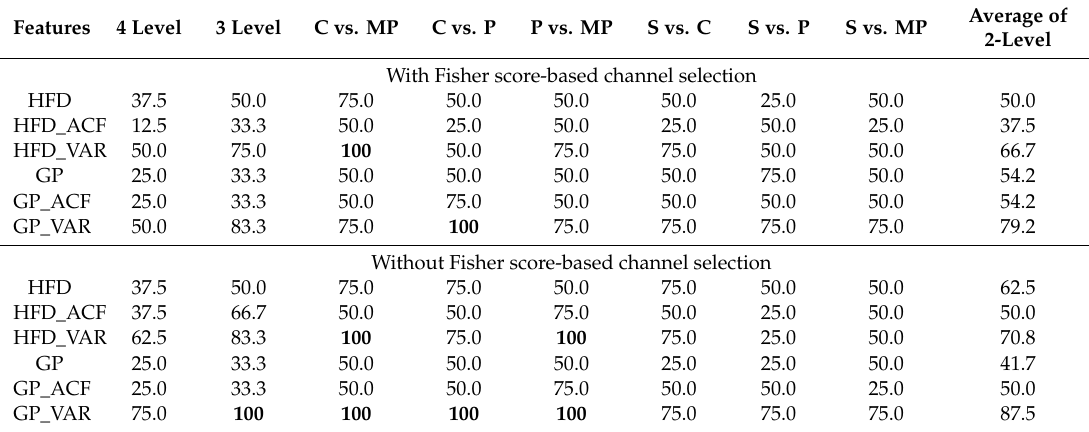
Table 3. Classification accuracy (%) of features from whole trial. Highest accuracy is shown in bold.